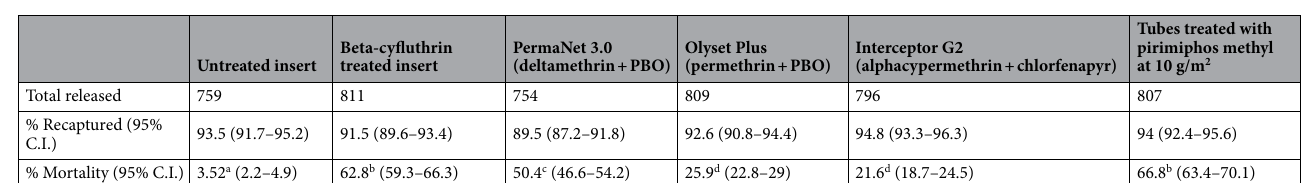
Table 1. Semi-field release-recapture results of insecticidal EaveTube against pyrethroid resistant Anopheles gambiae s.l. in enclosure. Values along a row bearing the same letter label are not significantly different (GLMMs, P >